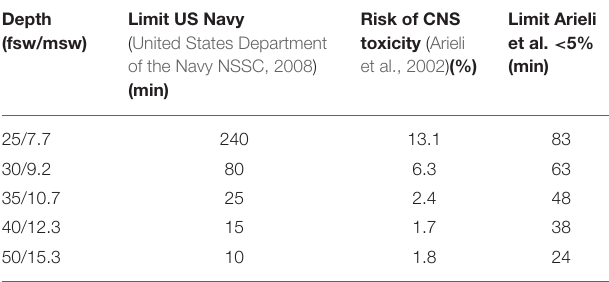
TABLE 1 | Single-depth oxygen